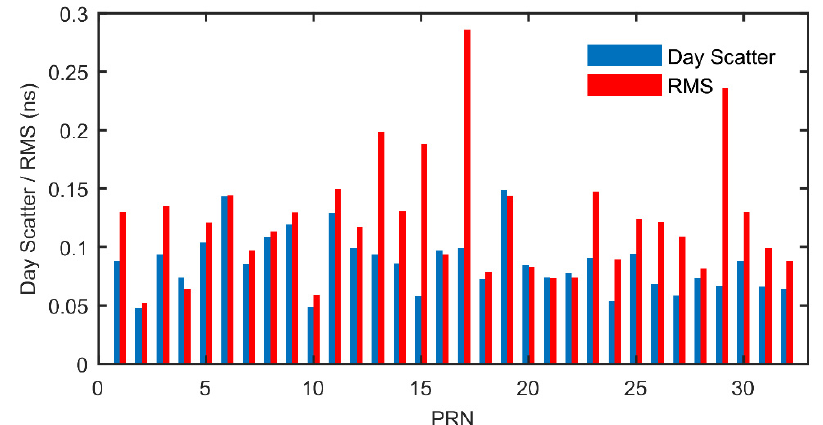
Figure 8. Day scatter of satellite DCB estimates determined by recursive method after selecting reference stations and corresponding RMS values with respect to CODE DCB during the period of interests.